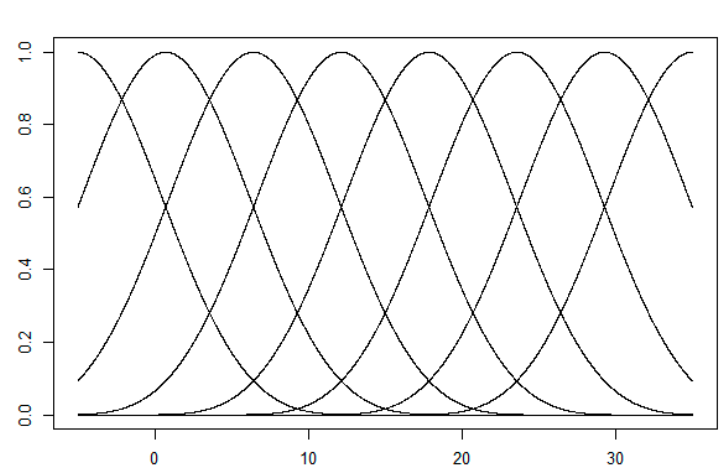
Figure A1. Distribution of spline basis functions based on landmarks.